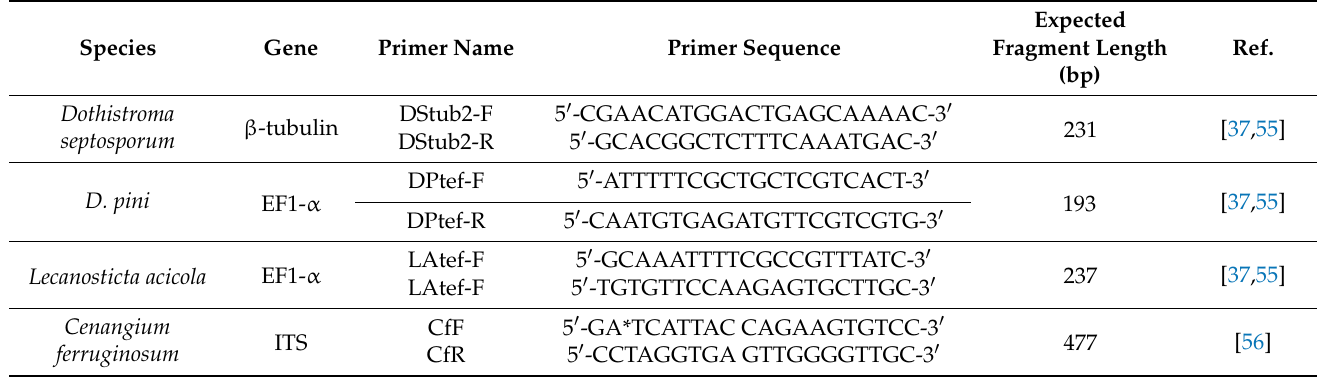
Table 1. Primers used for PCR detection of Pinus